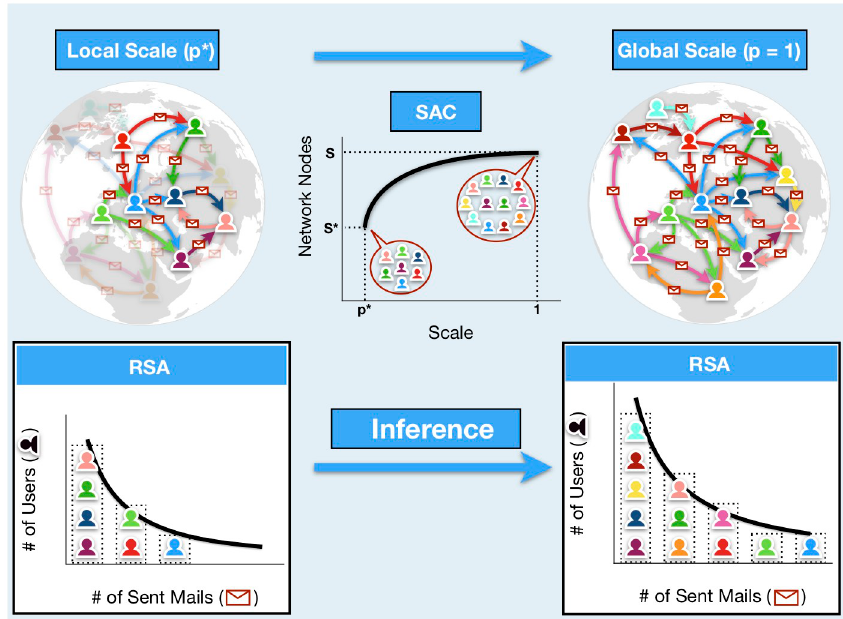
Fig 2. Sketch of our theoretical framework. Consider the email senders’ network where each node is a sender and a directed link from node A to node B is an email issued from user A to user B . We set the identity of a sender to be the species and a sent email to be an individual of that species. For instance, if the user A has sent n emails, then the species A has n individuals. If an observer has access to a fraction p � of the sent emails, s/he can partially recover the network (top-left) and the RSA curve at the local scale p (bottom-left). Within our framework, this information suffices to infer the number of species and the RSA curve at the global scale p = 1 (bottom-right). In terms of the network, the number of species corresponds to the number of users or nodes and the RSA gives the degree statistics. In this sense, our method reveals network features pertaining to the whole community activity initially unknown to the observer (top- right). Moreover, we can predict how the number of users increases with the number of links recorded, (i.e. the SAC curve in ecology), an information that may be used to optimize network design forecasting its